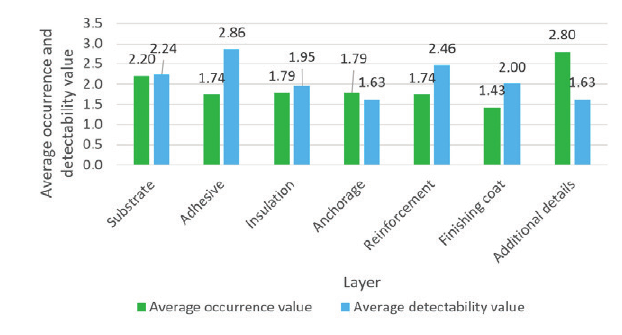
Figure 6. The average occurrence and detectability value by layers